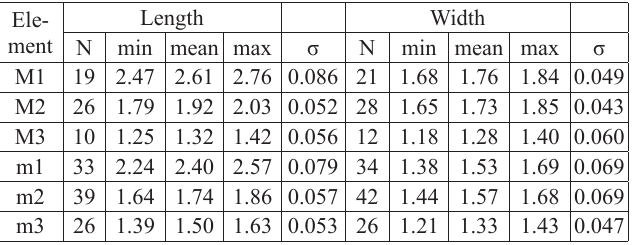
Table 1. Measurements (in mm) of the teeth of Paraethomys baeti­ cus sp. nov. from Baza-1, early Pliocene, Guadix-Baza Basin, Spain. σ, standard